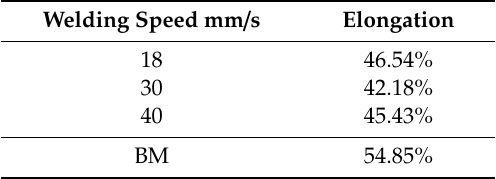
Table 3. Elongation and peak stress of base metal and FZ under di ff erent welding